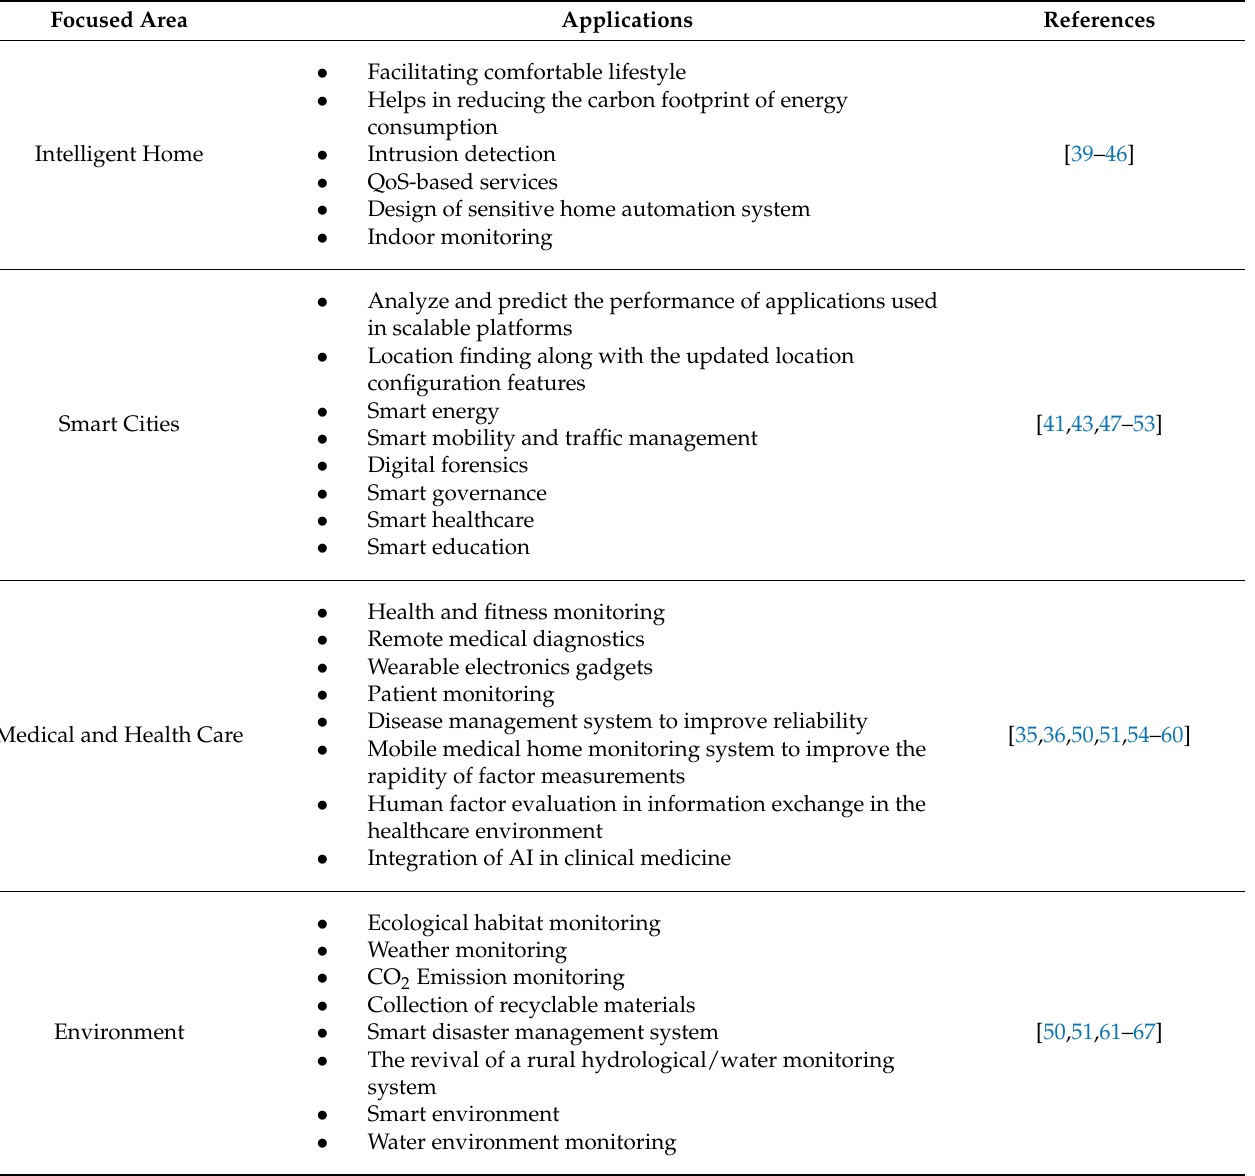
Table 2. Applications of the